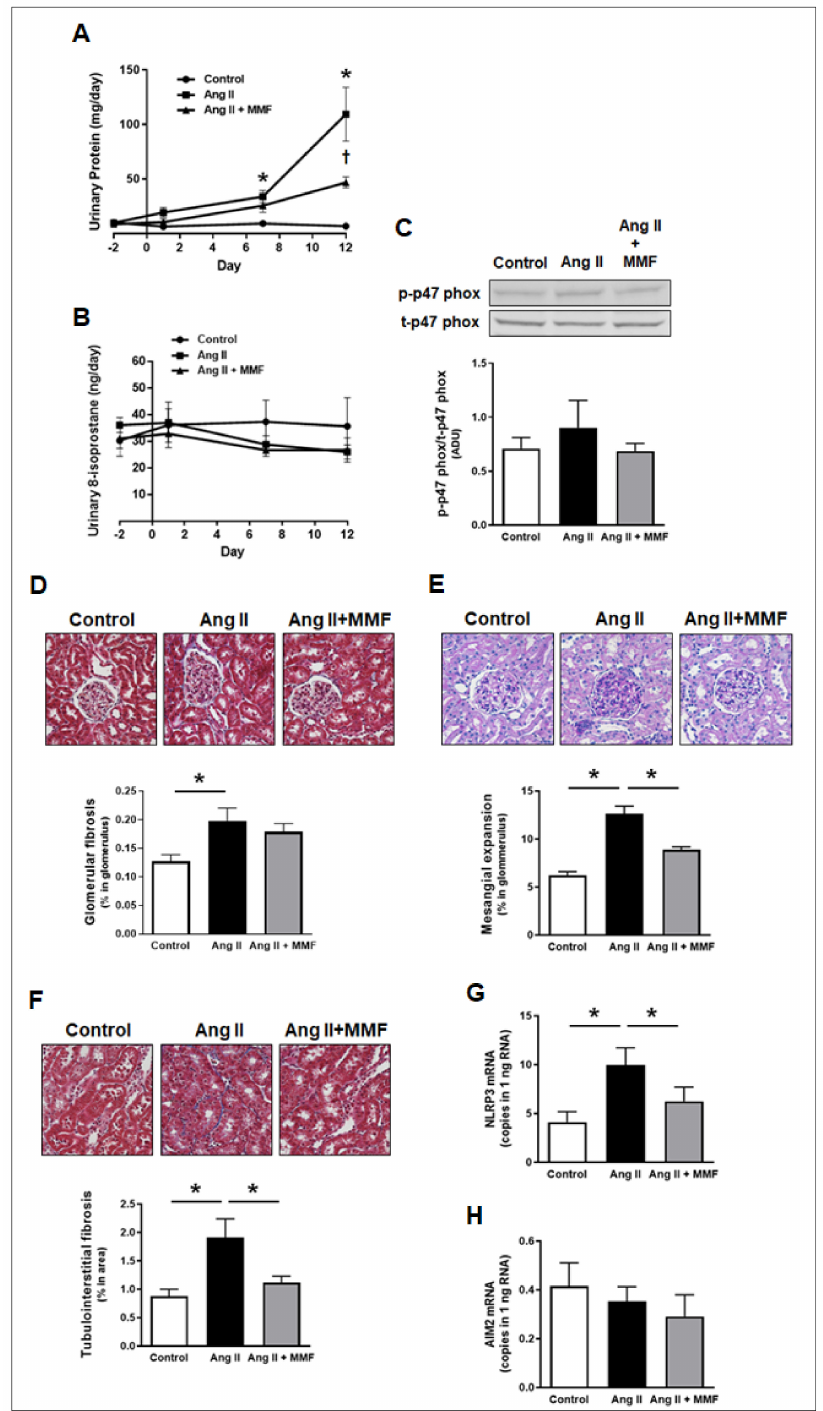
Figure 4. E Effects of MMF on hypertensive kidney injury. Panel ( A ) indicates urinary protein levels ( n = 6). Panels ( B , C ) show markers of renal oxidative stress, urinary 8-isoprostane and renal cortical phosphor-p47 phox levels, ( n = 6). Panels ( D – F ) are scores and representative pictures of glomerular fibrosis (MT staining, blue color indicates positive area. The bar graph shows the percentile of blue positive area in the total image or glomerulus.), glomerular mesangial expansion (PAS staining, pink color indicates positive area. The bar graph shows the percentile of pink positive area in the glomerulus.) and tubulointerstitial fibrosis (MT staining), respectively ( n = 6). Panels ( G , H ) indicate mRNA copy numbers of NLRP3 and AIM2 in the renal cortex detected by ddPCR ( n = 6). Asterisk ( p < 0.05) indicates significant difference between